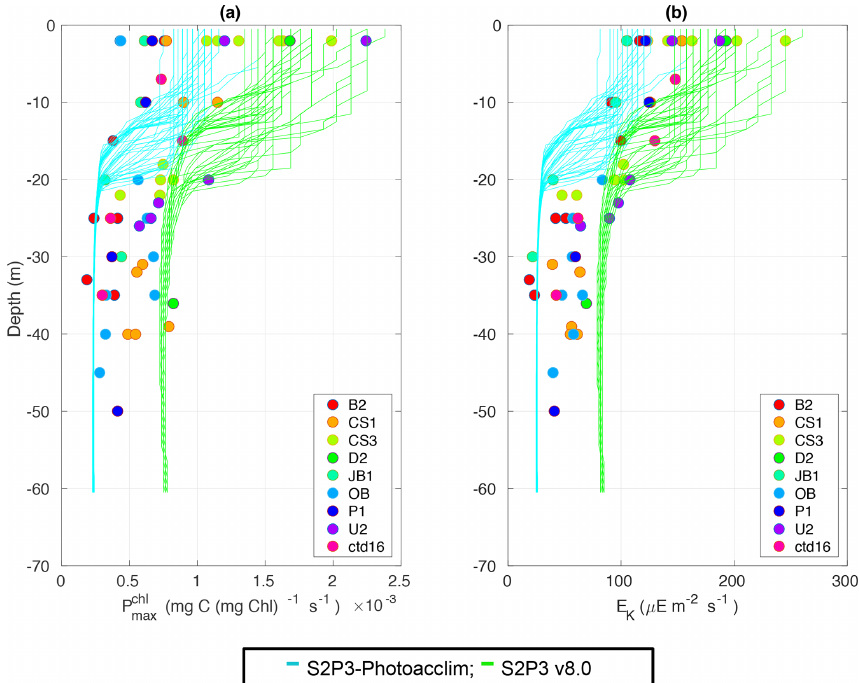
(cid:16) (cid:17) P Chl max